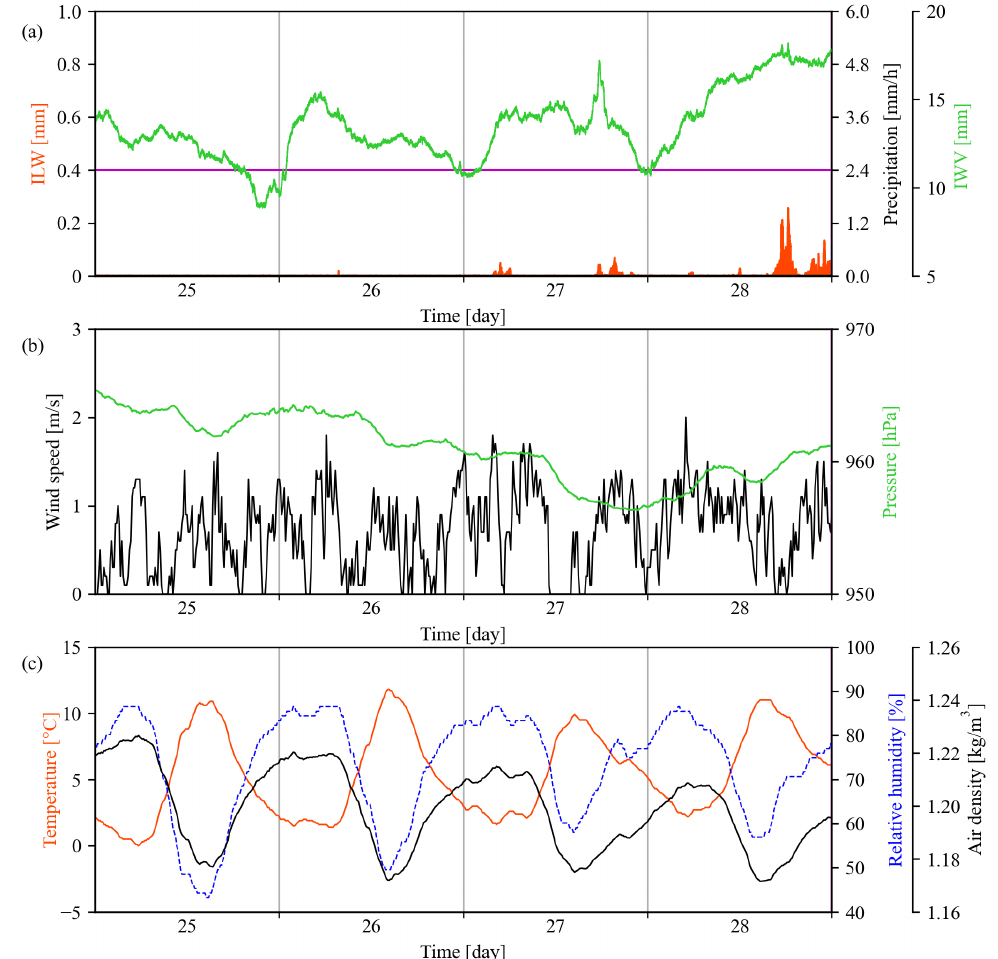
Figure 8. Time series of TROWARA and meteorological data from 24–29 January 2016. Between the two purple vertical lines is a long clear sky period that lasts from 25–28 January. ( a ) Time series of IWV (green line) and ILW (red area).The purple horizontal line is ILW = 0.4 mm. ( b ) Time series of surface pressure (green line) and wind speed (black line). ( c ) Time series of surface temperature (red line), relative humidity (blue dotted line), and air density (black